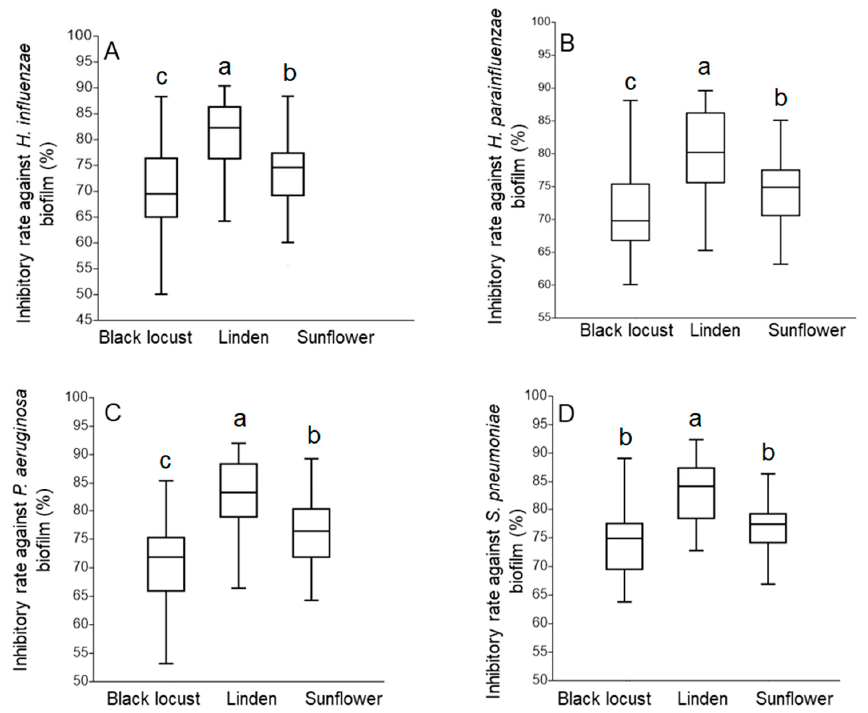
Figure 5. Biofilm inhibition activity of different honey samples against respiratory tract bacteria: ( A ) Haemophilus influenzae , ( B ) H. parainfluenzae , ( C ) Pseudomonas aeruginosa , and ( D ) Streptococcus pneumoniae . The anti-biofilm formation activity was calculated and demonstrated in terms of inhibitory rate according to the equation: Inhibitory rate = (1 − S/C) × 100% (C and S were defined as the average absorbance of control and sample groups, respectively). Different lower case letters (a, b, c) above boxes in figures ( A – D ) indicate significant differences at p ≤